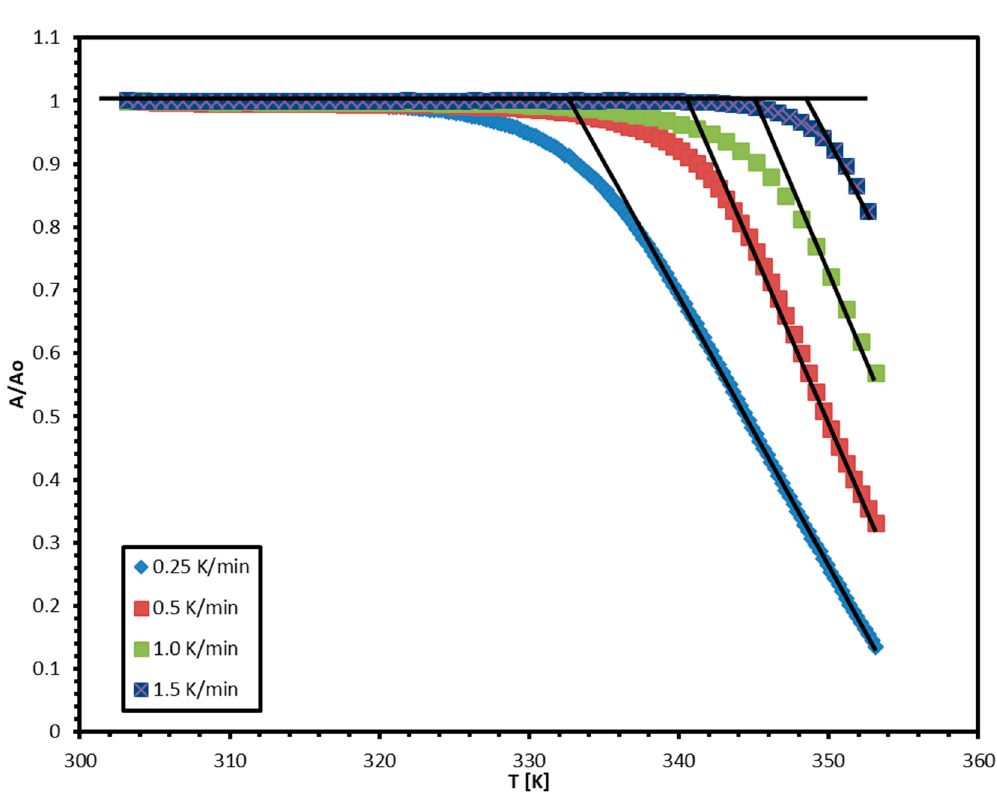
Figure 2. The effect of heating rate on the absorbance non-isotherms of TNT.